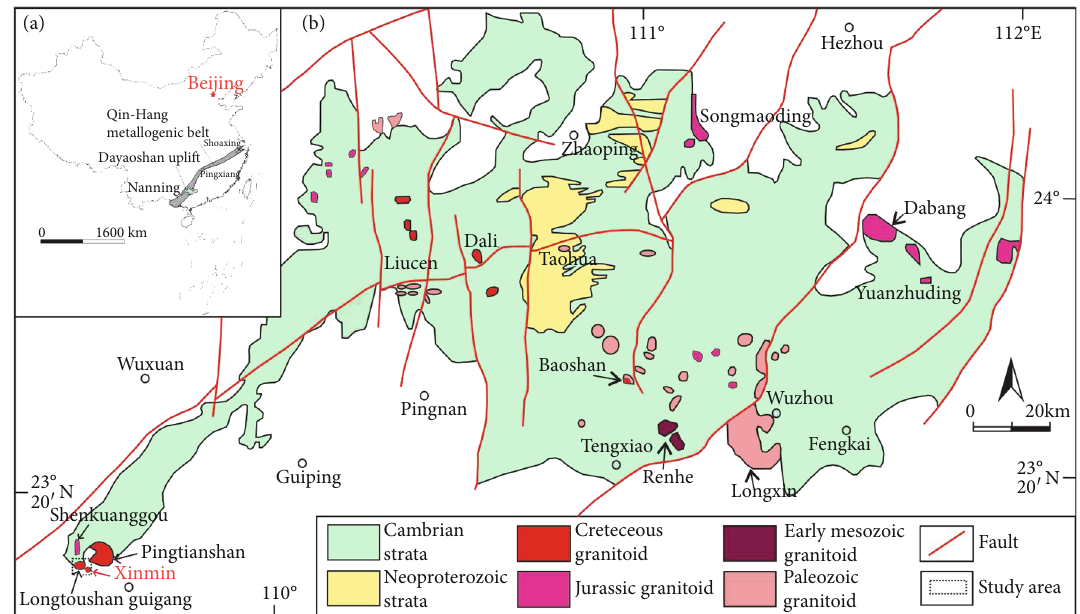
Figure 1: (a) Sketch map showing the location of Dayaoshan Uplift in the Qinzhou-Hangzhou metallogenic belt, South China. (b) Sketch map of the Dayaoshan Uplift. Modi fi ed after